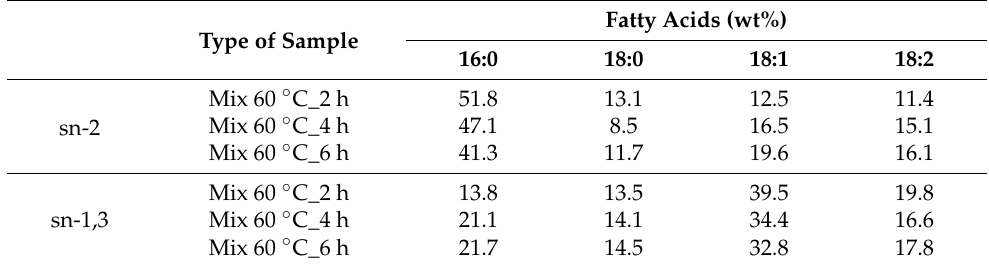
Figure 1. The percentage (wt%) of a given fatty acid in the sn-2 position of TAGs in lard (L), hemp seed oil (HO), human breast milk fat substitutes, and human milk fat. HMF * (human milk fat) sample values were derived from Lien [28]. Table 1. The fatty acid compositions of the sn-2 position and sn-1,3 positions of TAGs in human breast milk fat